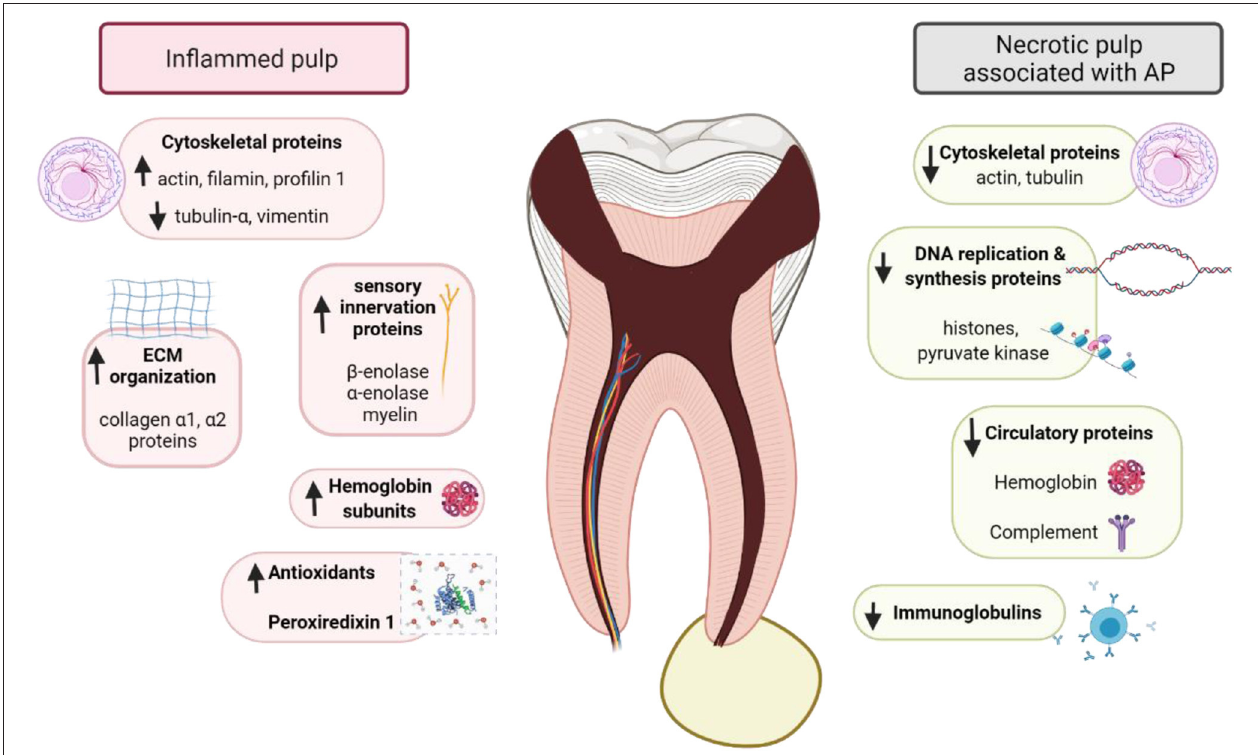
FIGURE 4 | Schematic representing different proteins expression and interactions in inflamed pulp and necrotic pulp associated with apical periodontitis (AP). Schematic created with